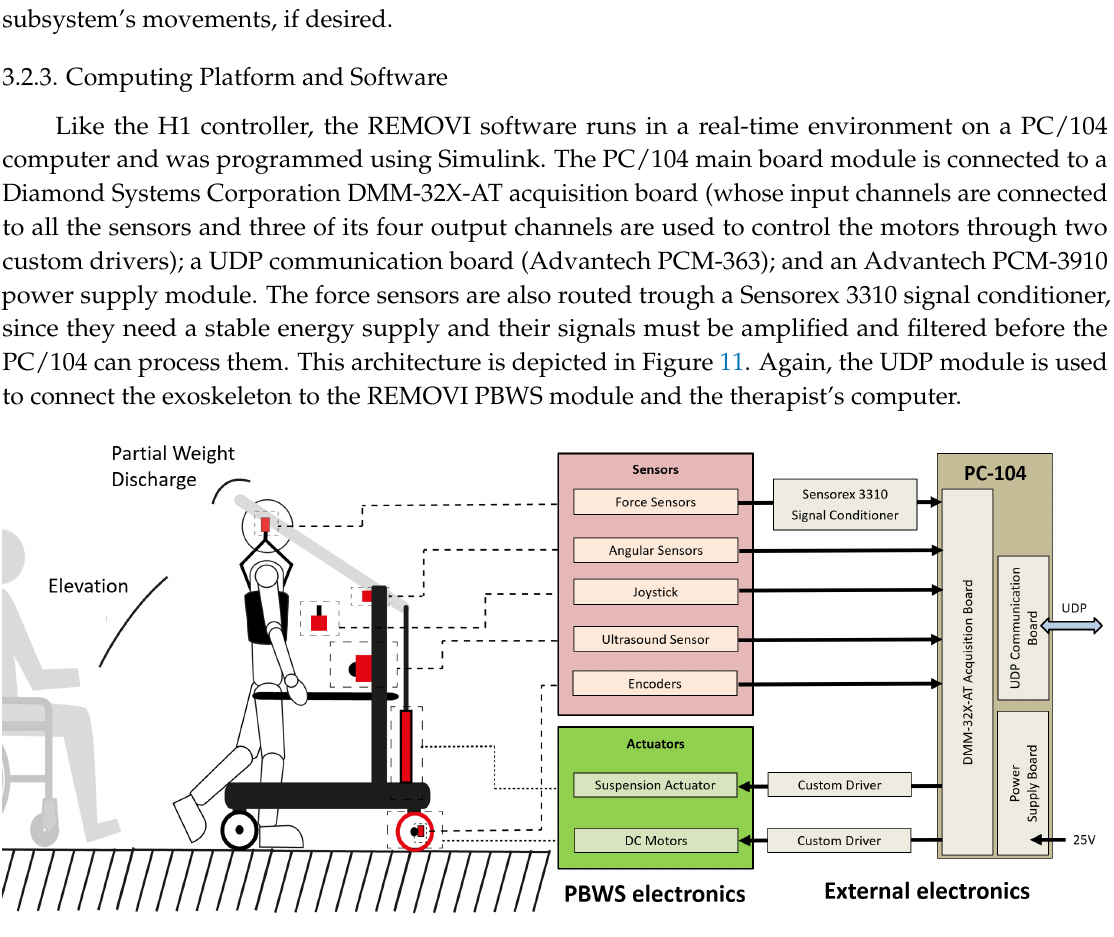
Figure 11. REMOVI electronics architecture. PBWS: partial body weight